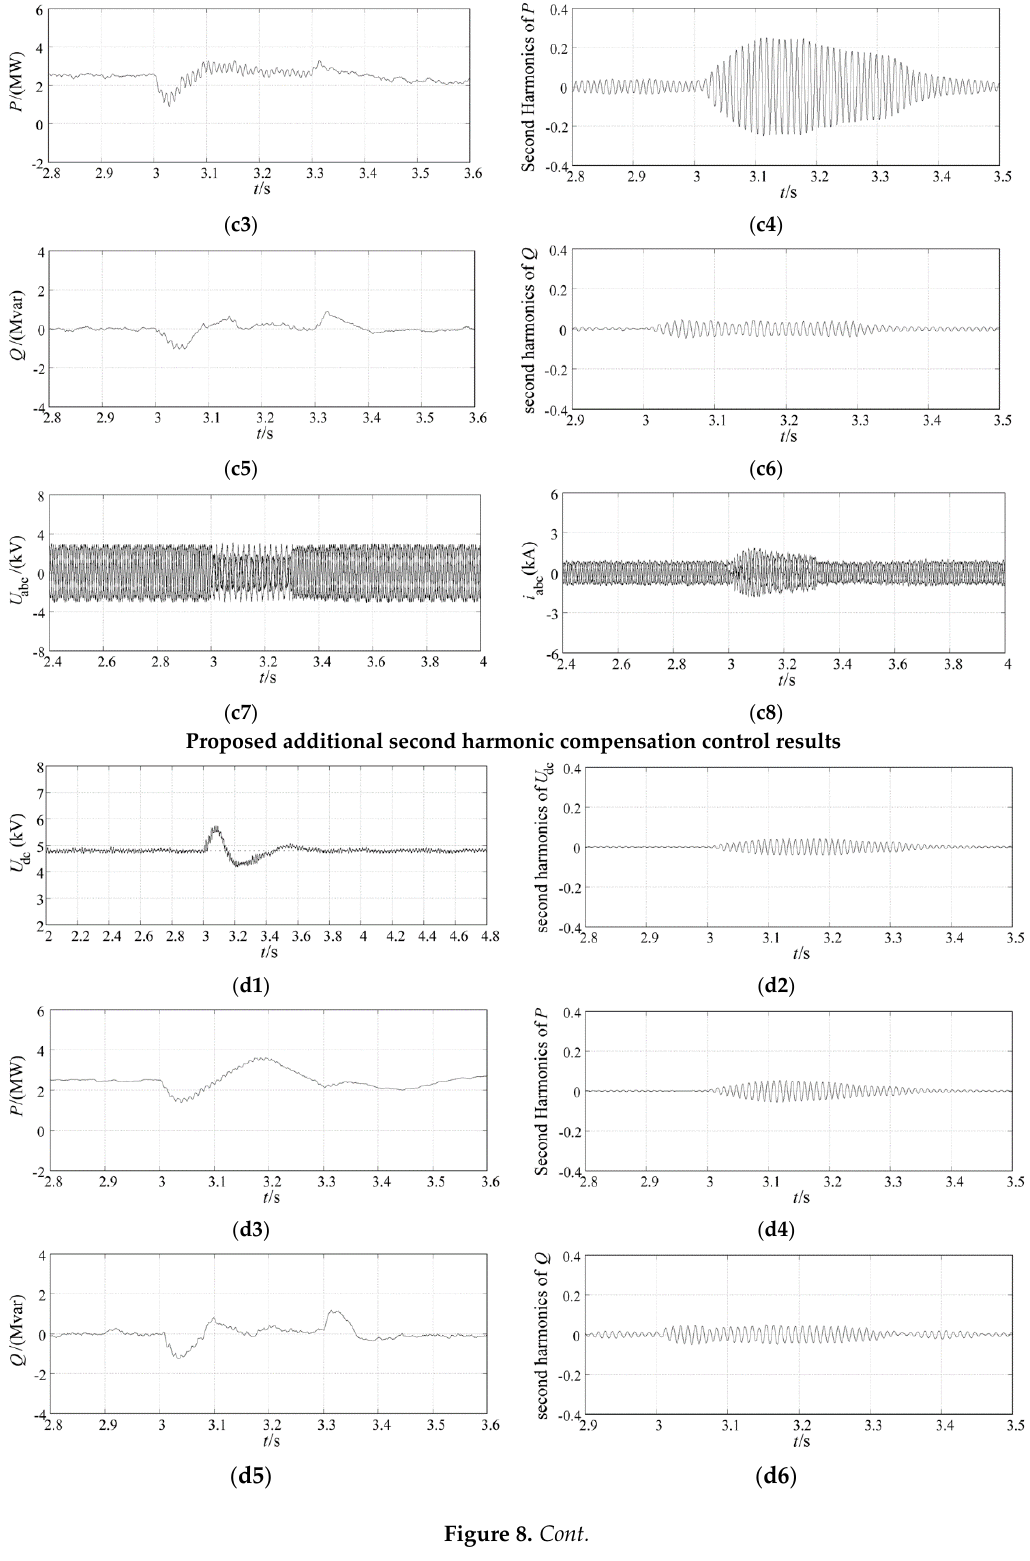
Figure 8. Cont. Figure 8.